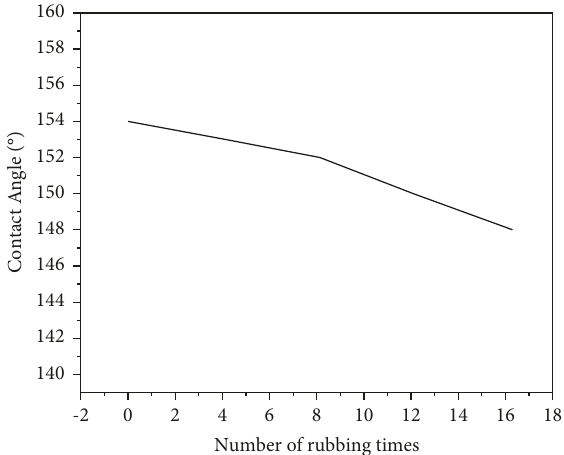
Figure 8: The contact angle of the surface of the round hole changes with the number of